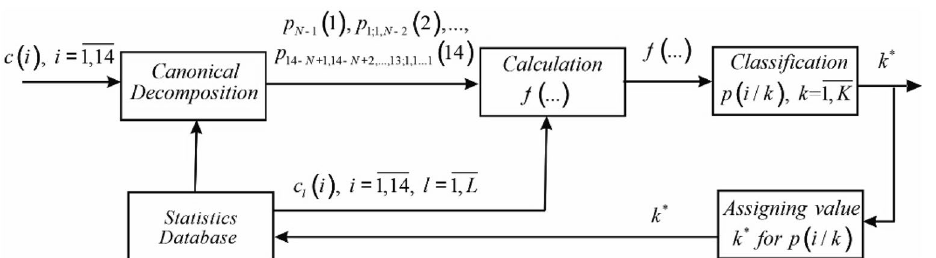
Figure 3. Diagram of the functioning of the system of diagnostics of cardiovascular